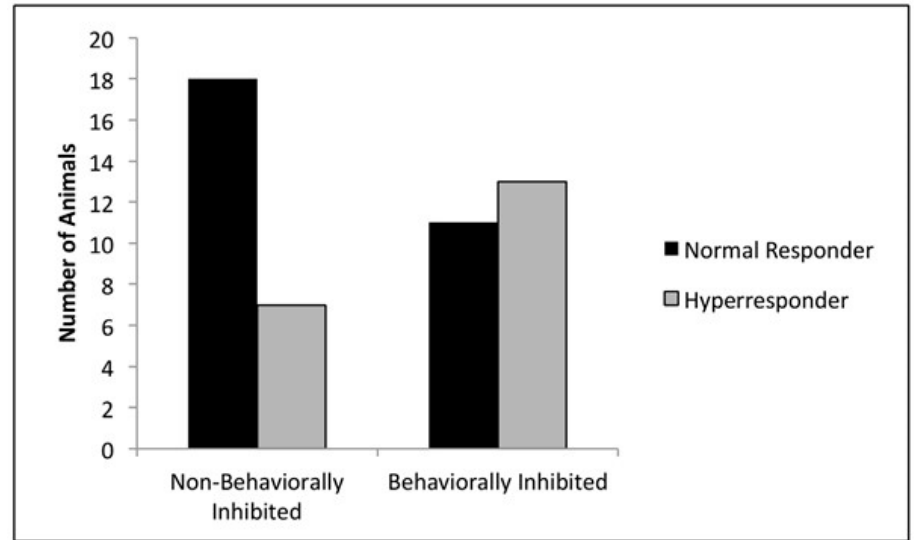
Figure 1. Inhibited temperament style and the airway response. Inhibited animals are significantly more likely to show an exaggerated airway response (i.e., to be a hyperresponder) compared to non-inhibited animals. Reprinted from [37].